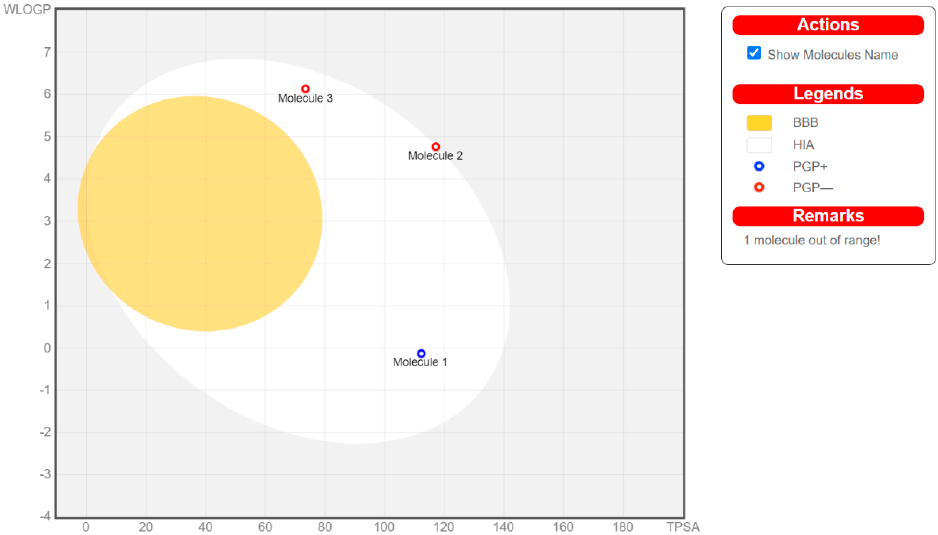
Figure 12. Brain or intestinal estimated permeation method (BOILED-Egg) chart for compounds 10 , 12 , 13 , and paclitaxel.